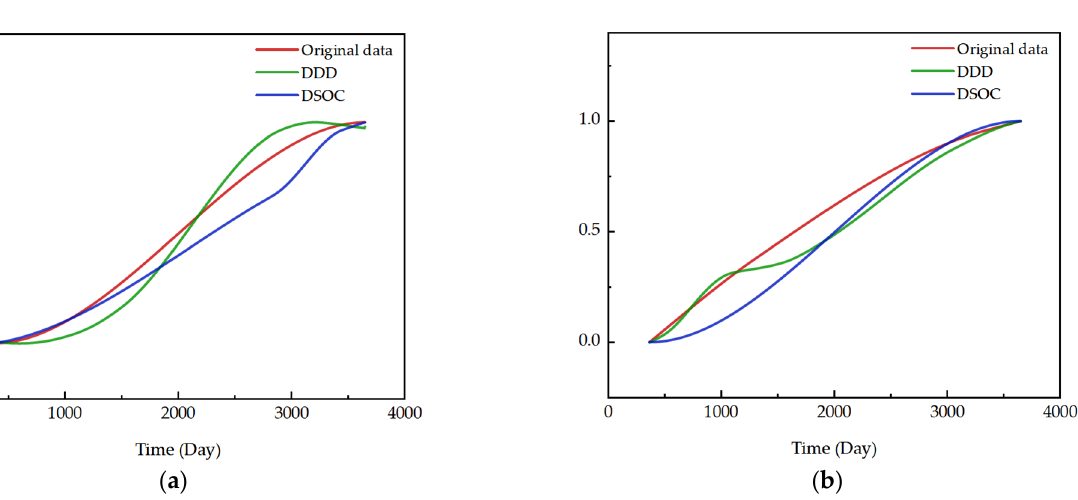
Figure 10. Comparison of three trends in ( a ) shell temperature and ( b ) bearing temperature after positive normalization.